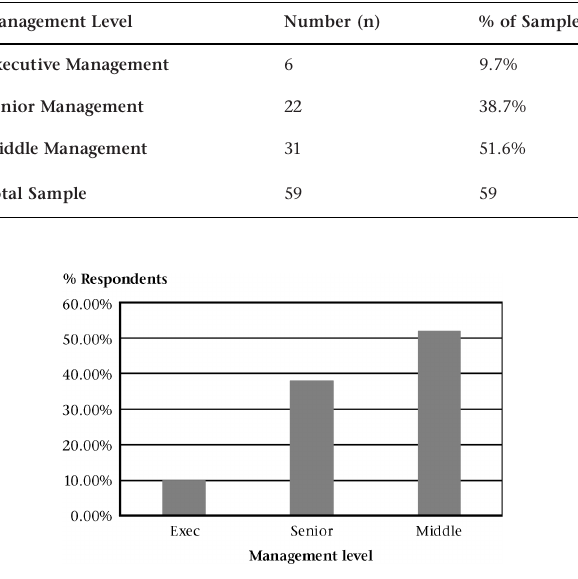
Figure 3: Management Level Analysis of